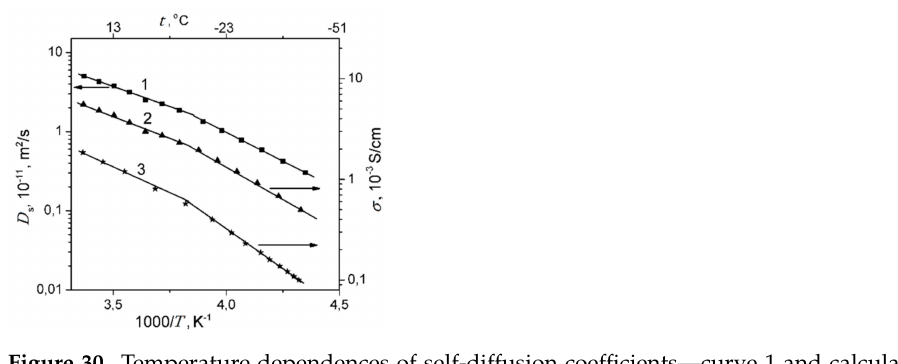
Figure 30. Temperature dependences of self-diffusion coefficients—curve 1 and calculated from Equation (7) protonic conductivity—curve 2, λ = 4.4 [25]. Curve 3—experimental temperature dependence of conductivity for λ g = 3.7 [112].